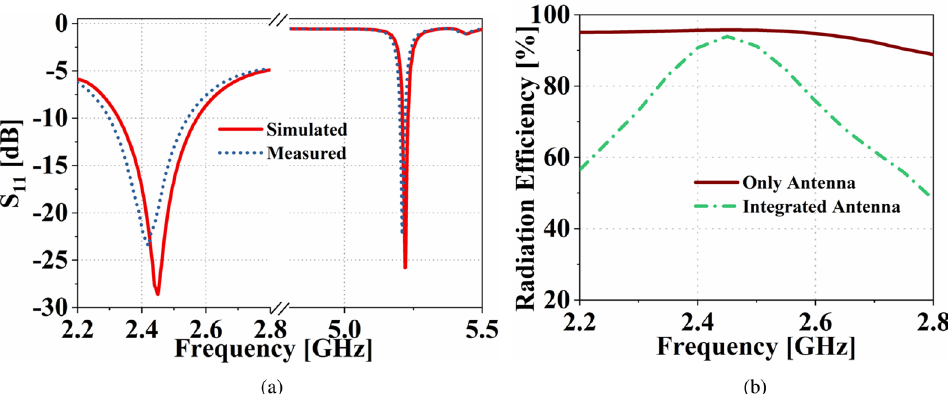
Figure 9. ( a ) The simulated and measured input reflection coefficient of the proposed dual-functional system. ( b ) Radiation efficiency of the the communication antenna before and after integration with the complete design.